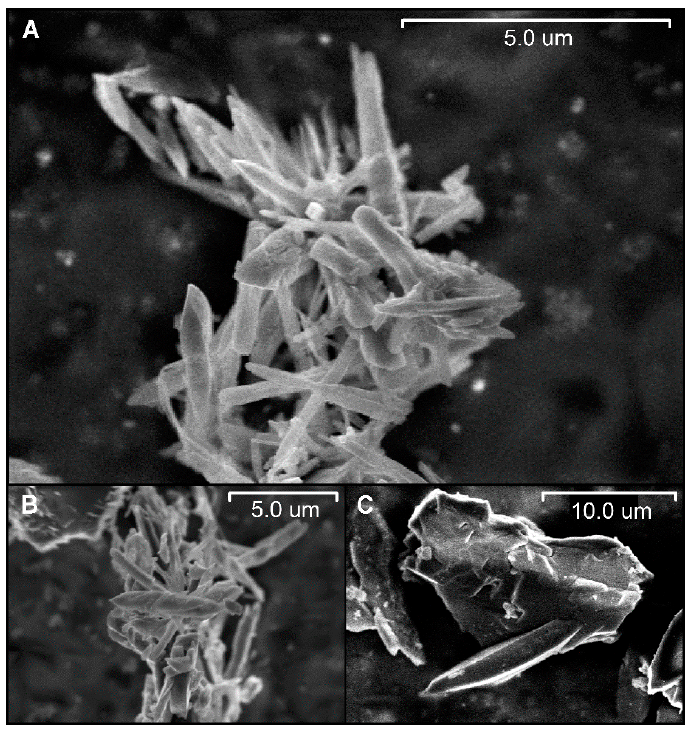
Figure 4. Scanning electron microscope images of [Zn 2 (bpdc) 2 (bpee)] powder. ( A , B ) [Zn 2 (bpdc) 2 (bpee)] microneedles; ( C ) [Zn 2 (bpdc) 2 (bpee)] aggregates.